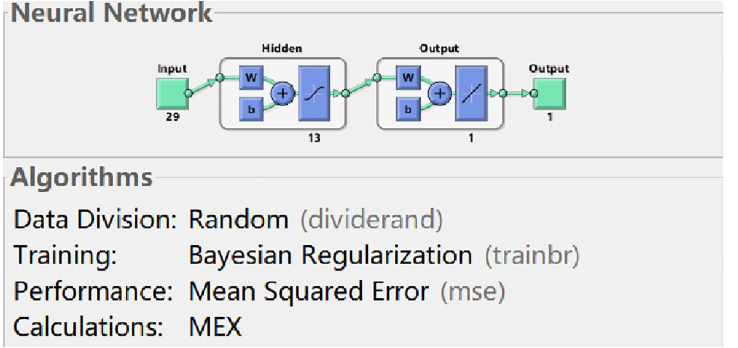
Fig 9. BP neural network structure